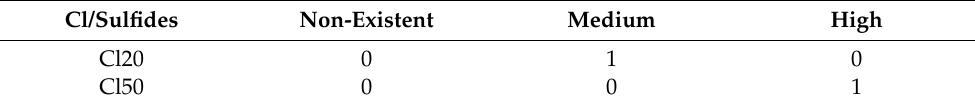
Table 1. Chloride concentrations versus sulfide